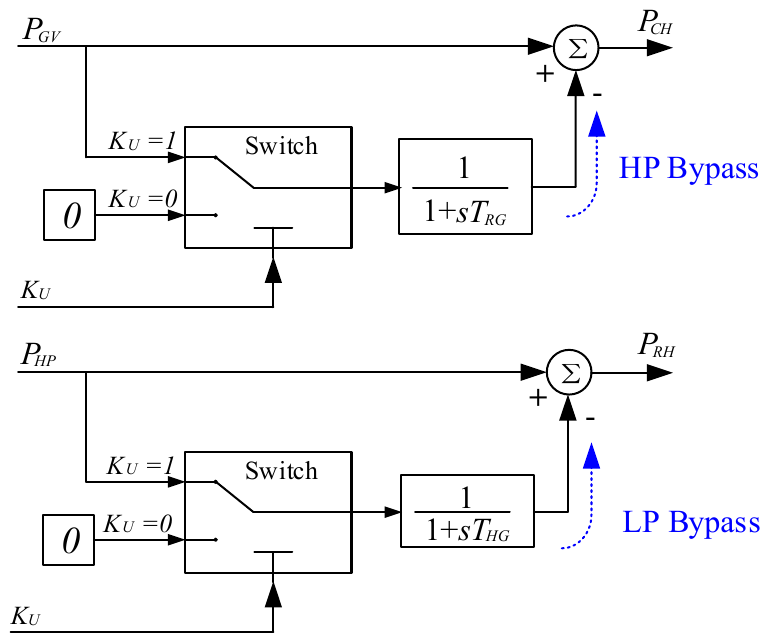
Figure 9. The model of the bypass and valve control